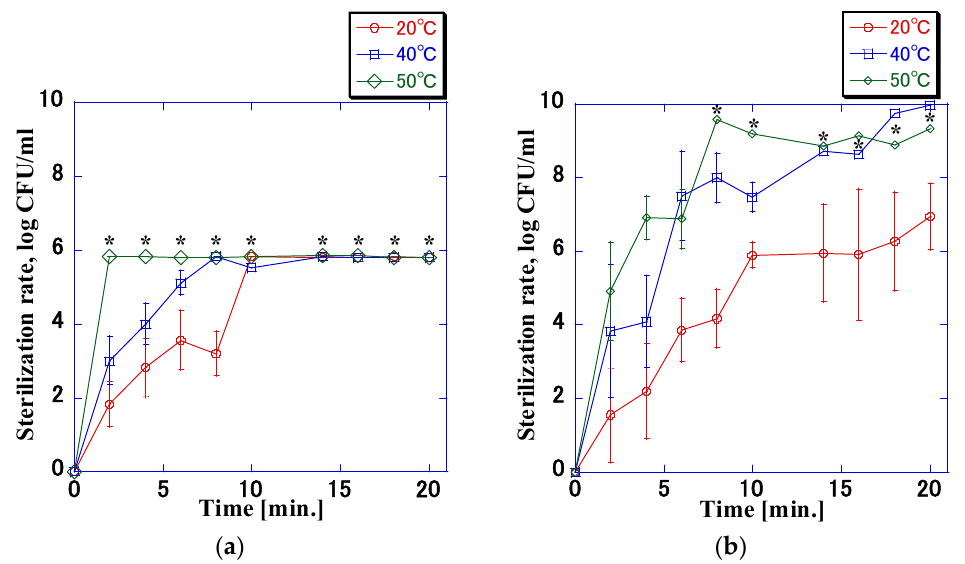
Figure 10. Variation in the sterilization rate when the temperature of the bacterial suspension was controlled (7.5 kV, 6.9 μ s, 200 Hz). The sterilization rate increased with the increase in temperature. When the bacterial suspension was at 40 °C and 50 °C, the sterilization rate increased significantly compared with that at 20 °C, and the rate was >9.0 log. Values calculated with the counts below the detection limit of quantification are marked with an asterisk; ( a ) 8.0 × 10 5 CFU/mL; ( b ) 8.0 × 10 9